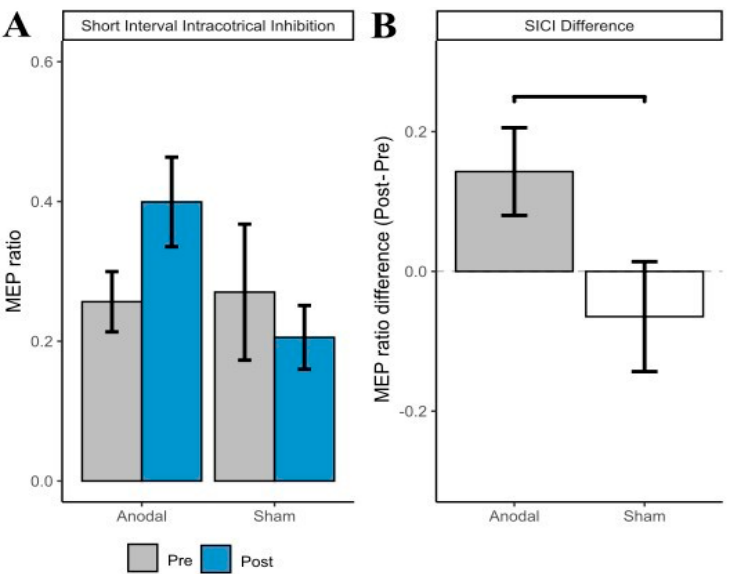
Figure 3. ( A ) Short interval intracortical inhibition (SICI) motor evoked potential (MEP) amplitude (with standard error of the mean error bars) at pre- and post-intervention by group. ( B ) SICI difference score (Post SICI MEP amplitude—Pre SICI MEP amplitude, with standard error of the mean error bars) by group.